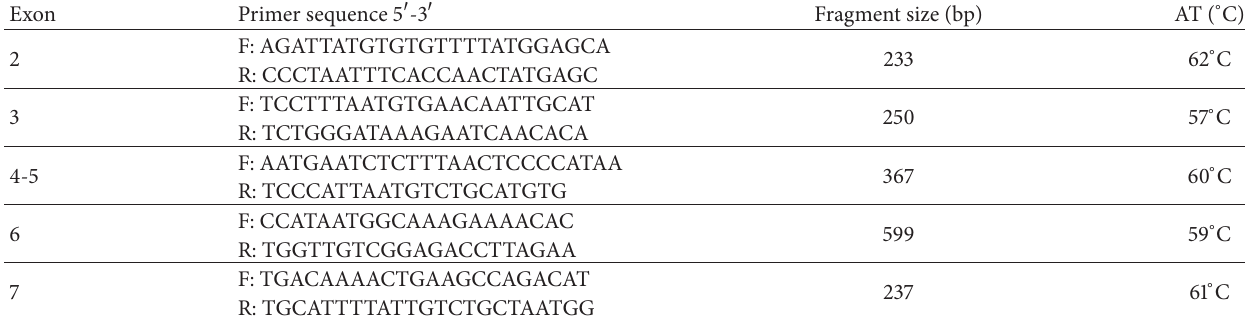
Table 1: Primers sequence (forward and reverse) of exons of the amelogenin gene and the PCR conditions.